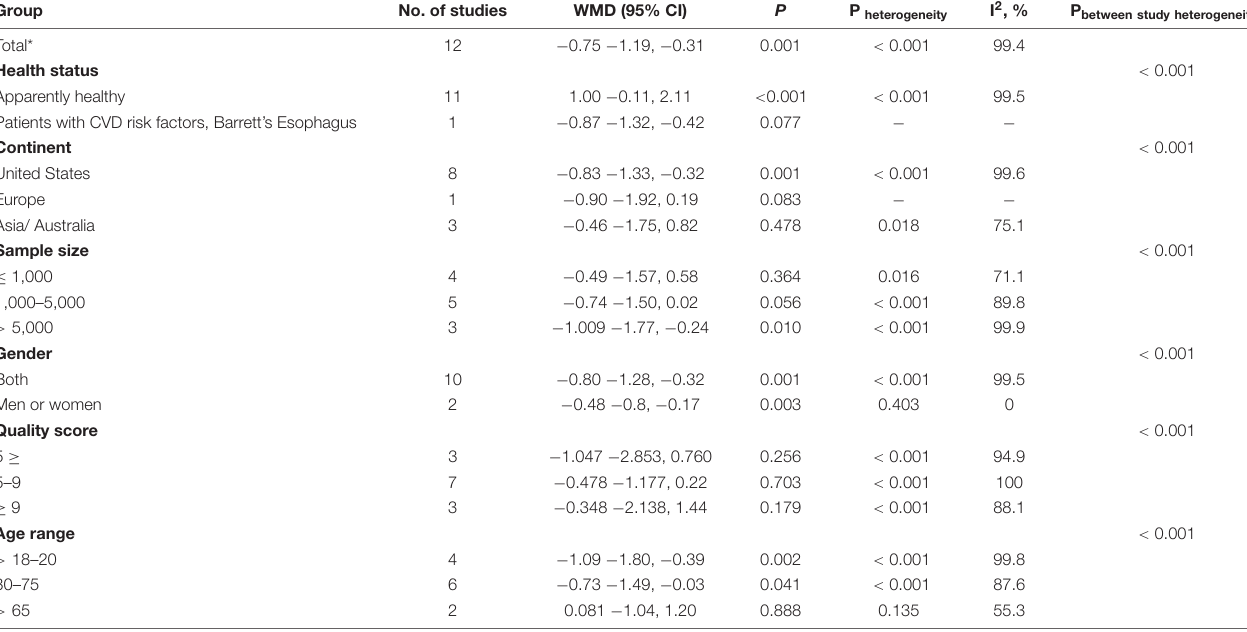
TABLE 3 | Results of subgroup analyses of the comparison of BMI in those with the highest vs. the lowest relative telomere length (rTLT) according to the study or participants “characteristics”. Group No. of